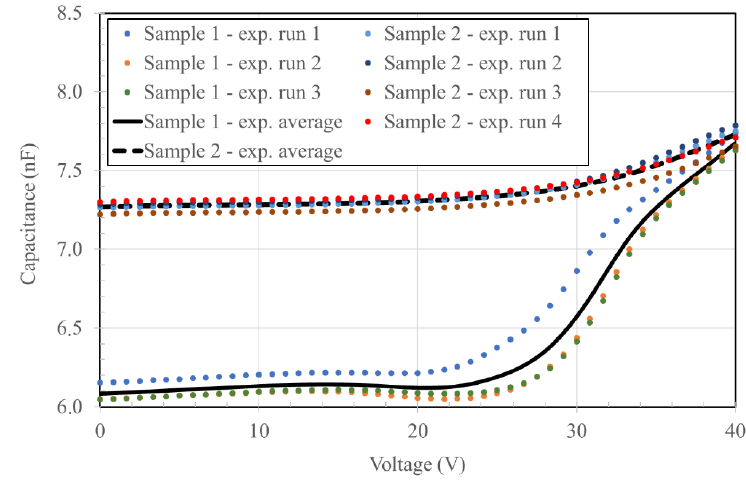
Figure 7. actuation voltage vs. mirror capacitance profiles.